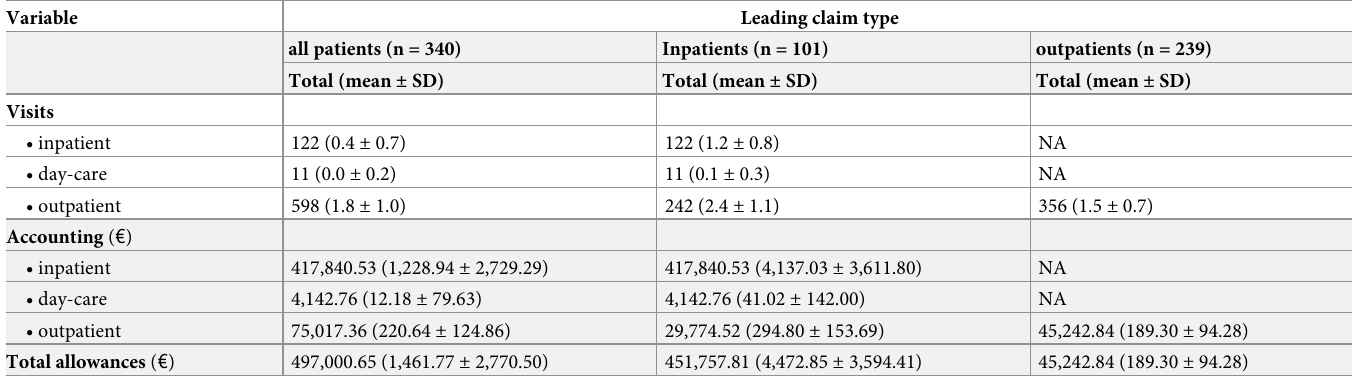
included in the given DRG. In the first and second quarters of 2017, the allowance of the hospi- tal‘s outpatient treatment amounted € 107.64 and € 147.12 in the third and fourth quarters. Referring to the leading claim type, the inpatient cohort (n = 101) accounted for 122 inpa- tient stays with a total of 753 (6.4 ± 2.8) days of hospitalization, 11 day-care treatments and an additional 242 outpatient claims with a total of 345 visits. Inpatient stays amounted with € 417,840.53, day-care treatment with € 4,142.76 and outpatient treatment with € 29,774.52 (Table 2). For the outpatient cohort, 359 visits of 239 individuals were documented in 2017. Due to the quarterly accounting this resulted in 356 outpatient cases. The allowance for leading outpa- tient claim type totaled up to € 45,242.84 (Table 2). Table 2. Direct medical